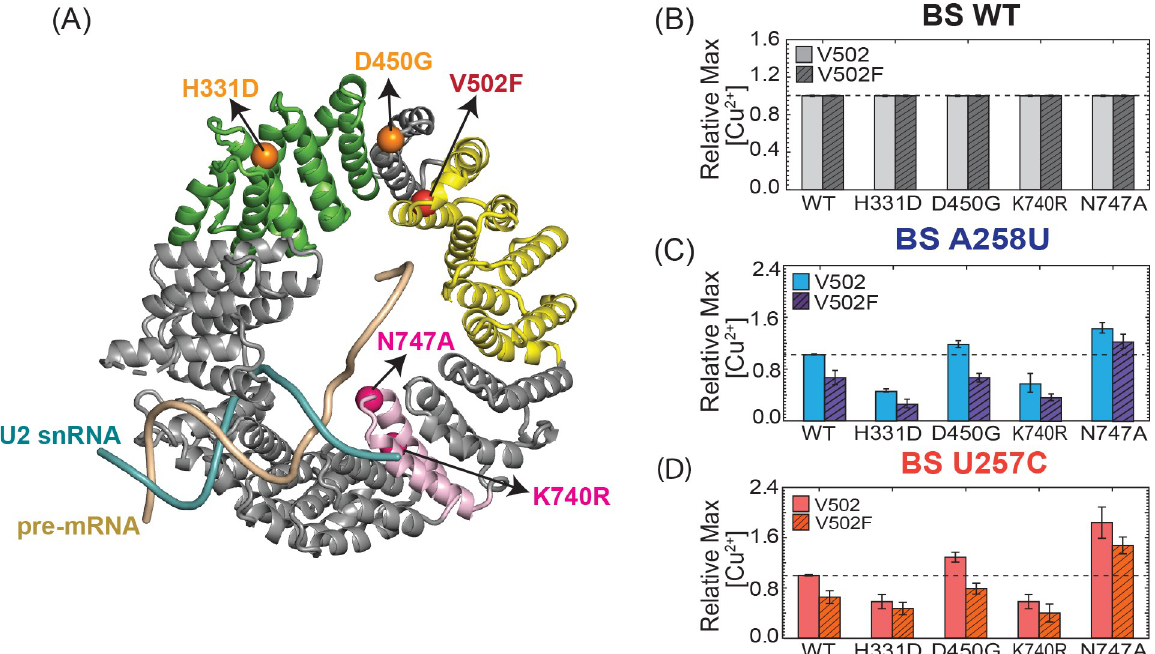
Fig 4. Effects of Hsh155 V502F in combination with mutations in other HR. (A) Hsh155 mutations found in different HR are mapped on to the structure of yeast Hsh155 present in the B complex spliceosome (PDB ID: 5NRL). (B-D) Results of ACT1-CUP1 Cu 2+ growth assays of Hsh155 WT and HR-mutant strains carrying WT or nonconsensus ACT1-CUP1 reporter plasmids. Each bar graph represents the average and standard deviation from three replicates of the maximum [Cu 2+ ] at which yeast strain survived relative to WT Hsh155.